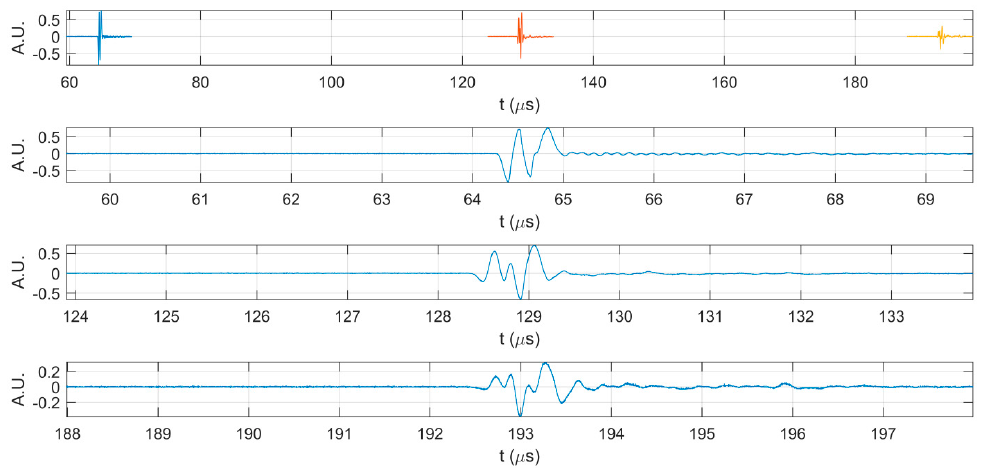
Figure 2. The first three echoes acquired for double-distilled water: together ( top ); and separated ( below ).